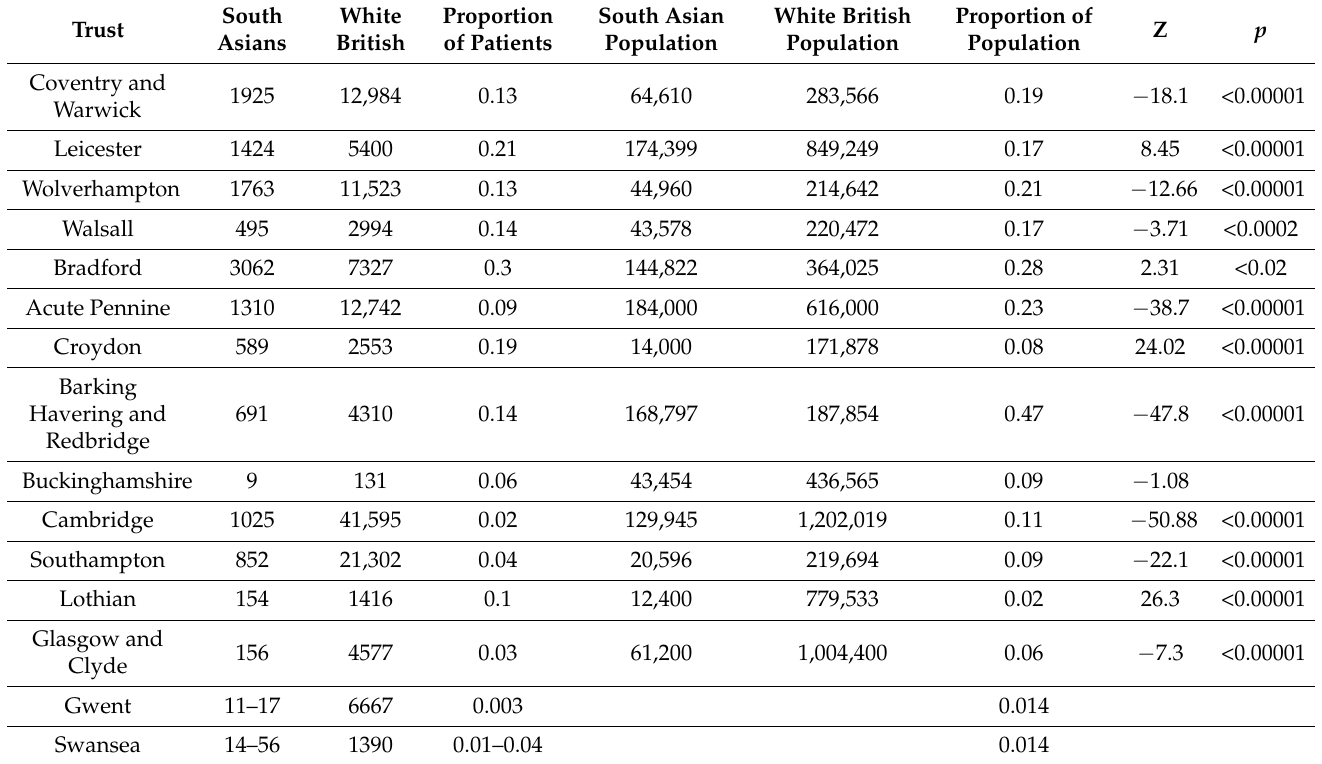
Table 2. Hospital admissions each year over the period 2015–2019 for Crohn’s Disease and Ulcerative